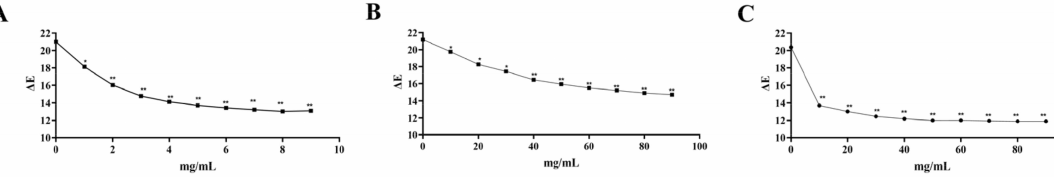
Figure A4. The effect of concentration of compounds on colour differences in anthocyanin solution. ( A ) ACNs − PX; ( B ) ACNs − ECT; ( C ) ACNs − DG. Compared with the group at 0 mg/mL, * p < 0.05, ** p <